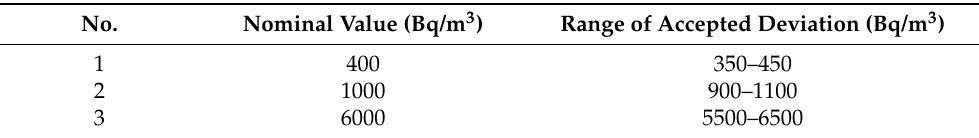
Table 2. Nominal levels of the radon activity concentrations for the exposure of the comparison